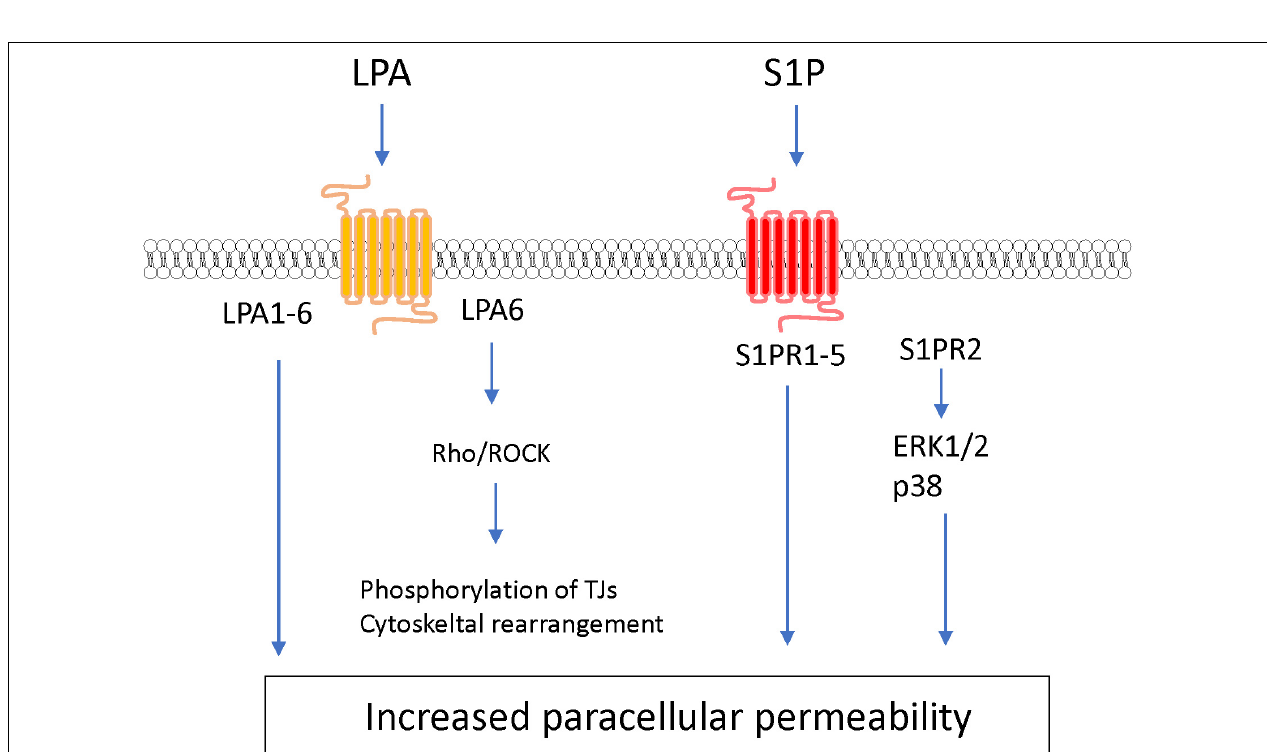
FIGURE 6 | Intracellular signaling pathways induced by lysophosholipids in BMECs leading to BBB dysfunction.